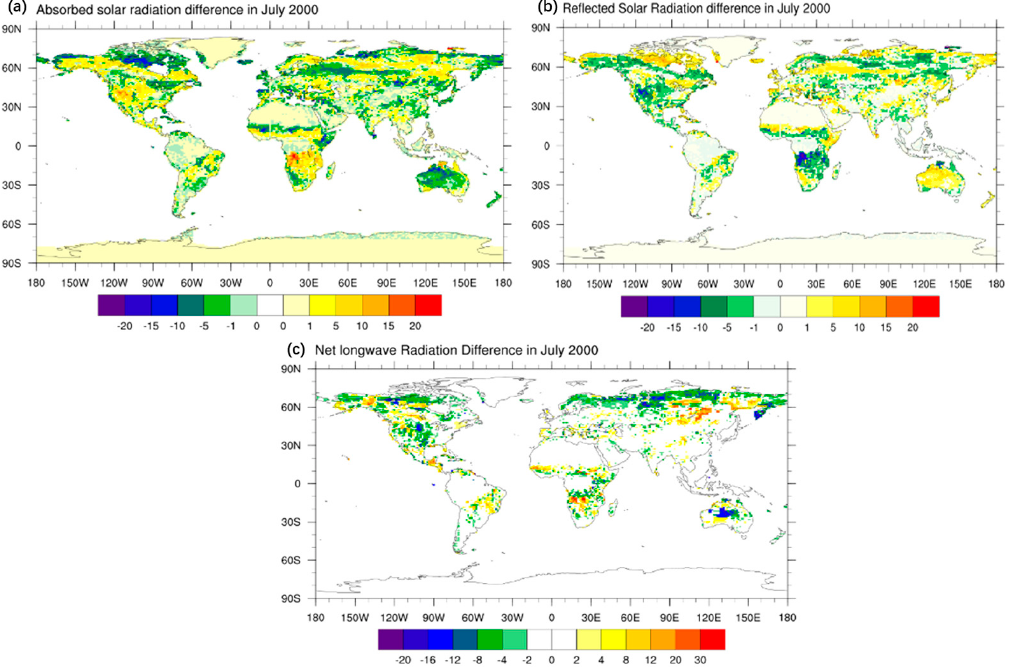
Figure 3. The difference of ESACCI and CLM_LS for ( a ) absorbed solar radiation (ASR), ( b ) reflected solar radiation (RSR), and ( c ) net longwave radiation (NLR) (unit: W/m 2 ) (July 2000).